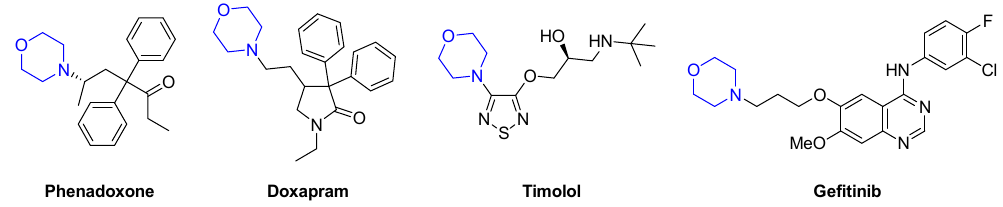
Figure 1. Morpholine containing drugs.